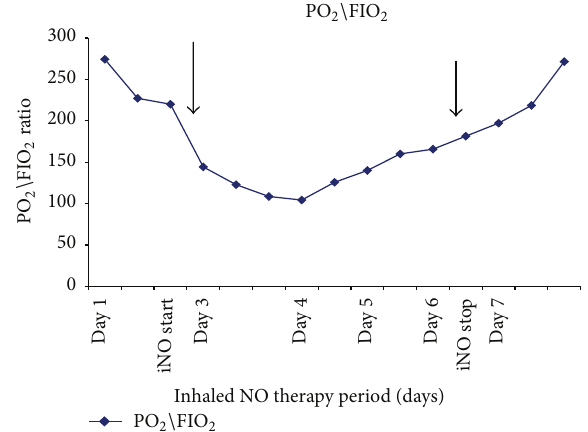
Figure 2: Changes in PO 2 /FiO 2 ratio during the second patient’s ICU stay. Inhaled NO therapy was initiated on the third day of the patient’s hospitalization (represented by the first black arrow) due to severe unresponsive persistent hypoxemia (PO 2 /FiO 2 -120). By the sixth day after hospitalization, the PaO 2 /FiO 2 ratio was improving and inhaled NO therapy was discontinued (represented by the second black